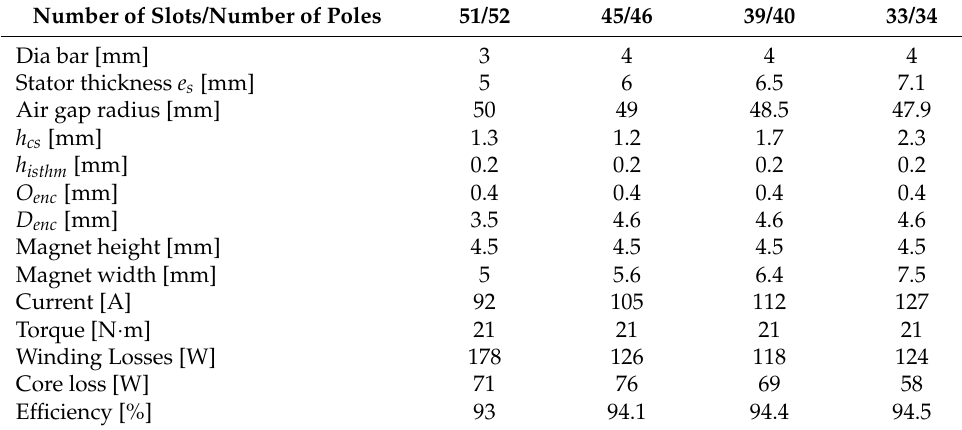
Table 5. Summary of the FEA results for different N s